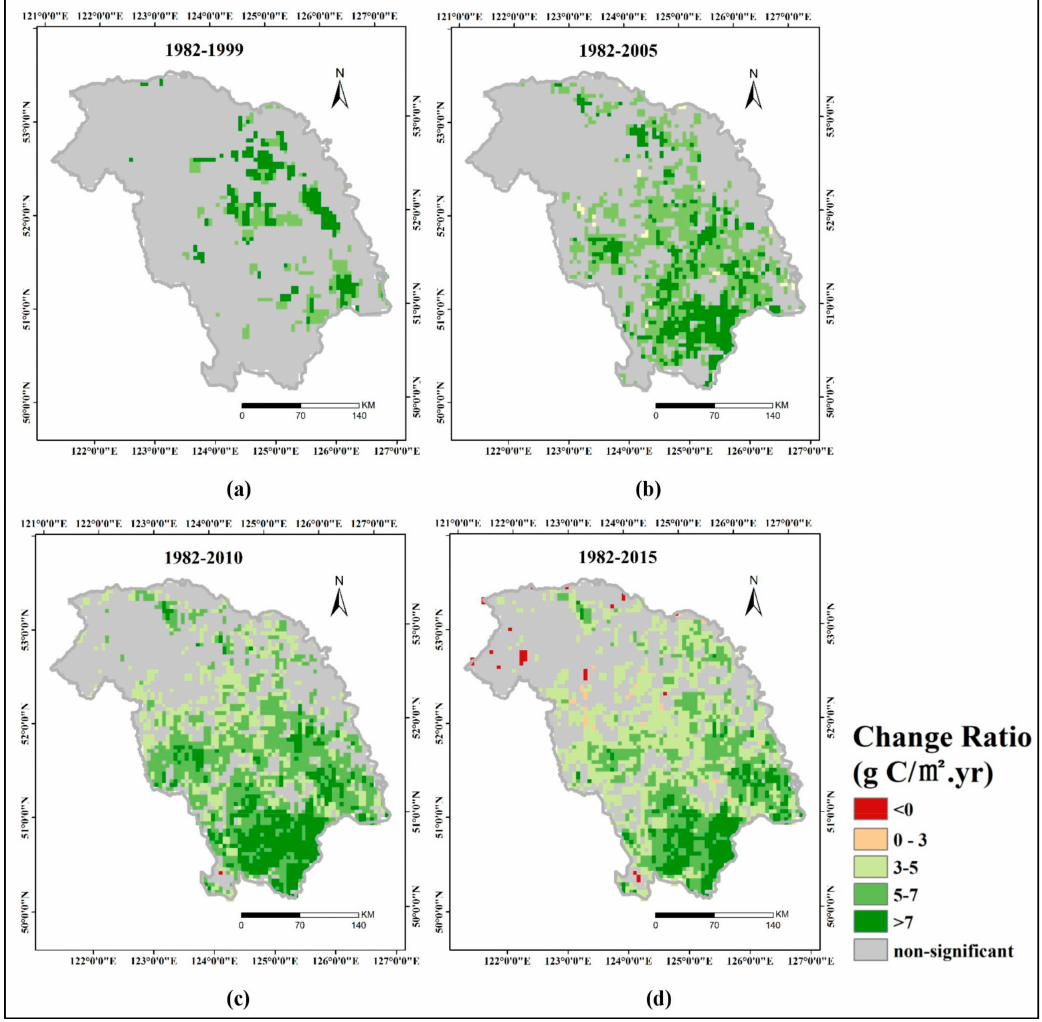
Figure 6. Spatial distribution of AGG trends across the GKM during the periods of ( a ) 1982–1999; ( b ) 1982–2005; ( c ) 1982–2010; and, ( d ) 1982–2015. The linear trends of the AGG were calculated at the 95% confidence